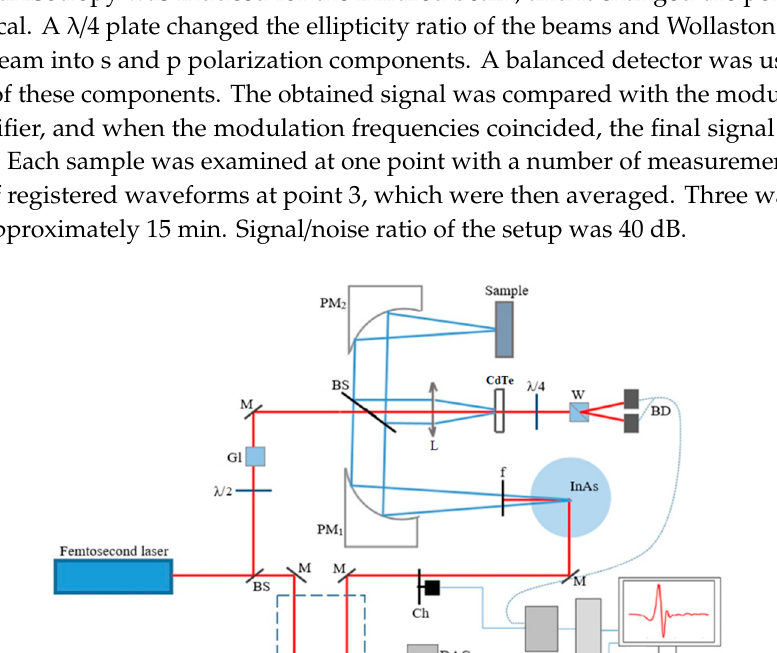
Figure 3. ( a ) Incident wave propagation in the double-reflection measurement method. 𝐸(cid:3552) (cid:2868) —incident THz field, 𝐸(cid:3552) (cid:3045)(cid:3032)(cid:3033) , and 𝐸(cid:3552) (cid:3046)(cid:3028)(cid:3040) —the THz field reflected from the air—window and window-sample interface, respectively. 𝑛 (cid:3028) , 𝑛 (cid:3050) , and 𝑛 (cid:3046)(cid:3028)(cid:3040) are the refractive indices of air, window and sample, respectively; ( b ) THz time-domain waveform corresponding to a tissue (mucosa).